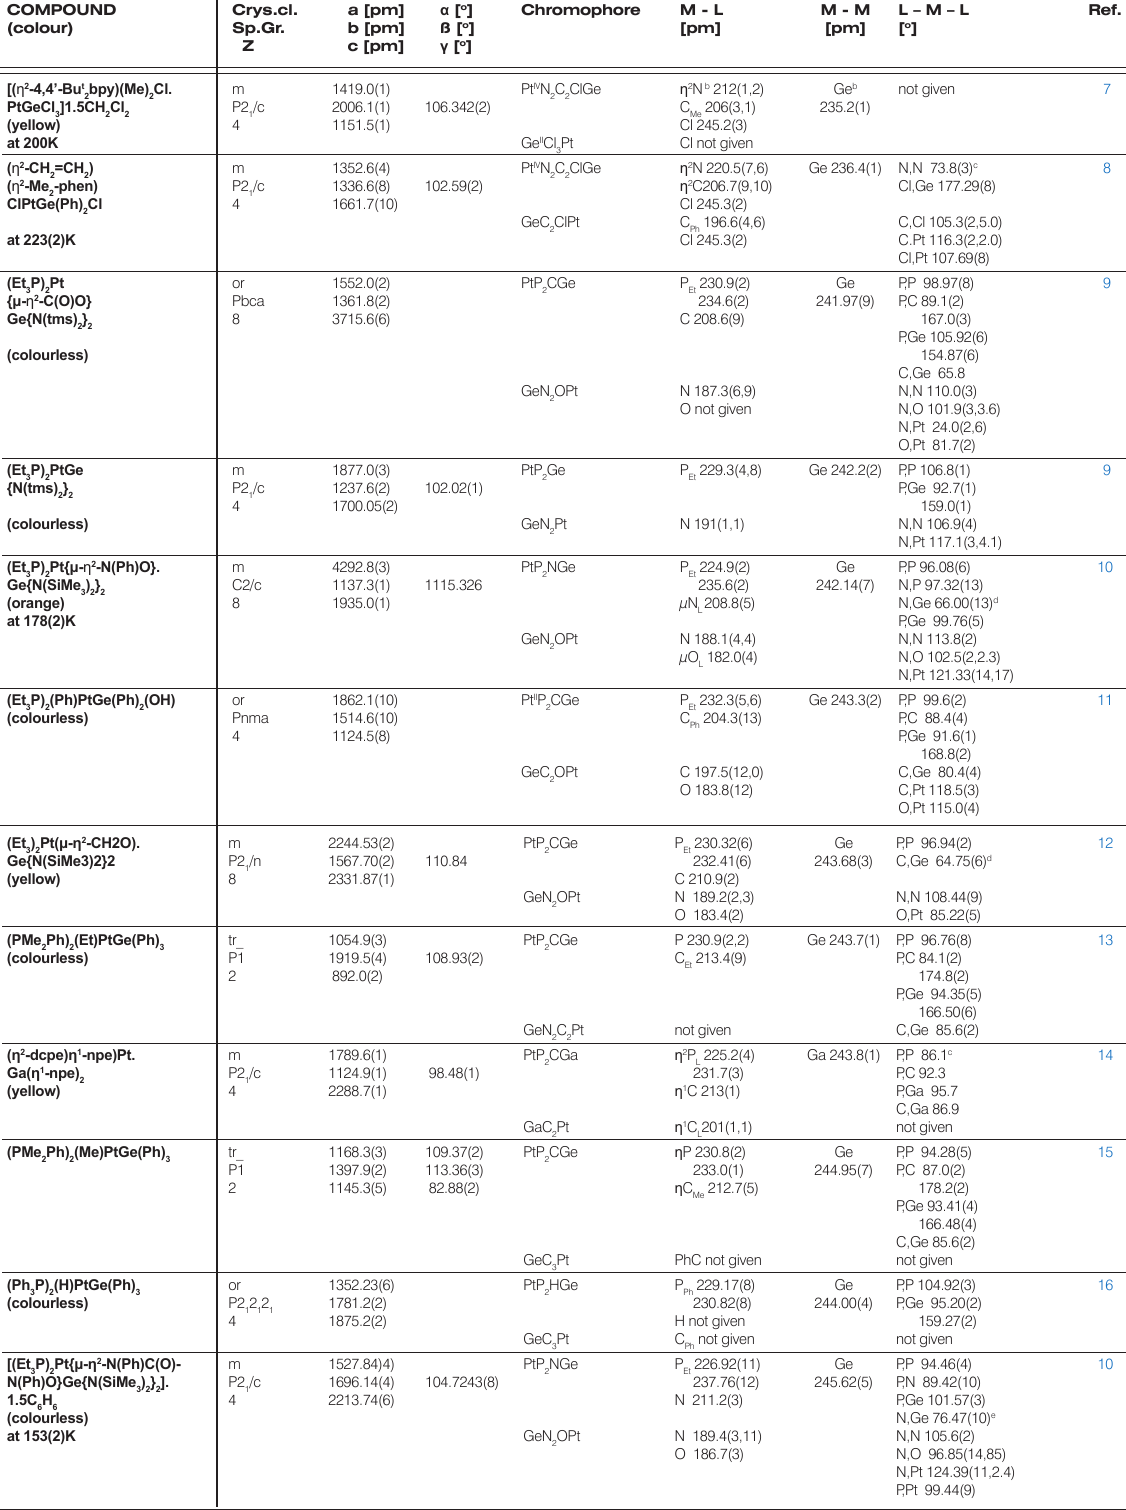
Table 1. Heterobinuclear platinum compounds with M = main group metal atom a